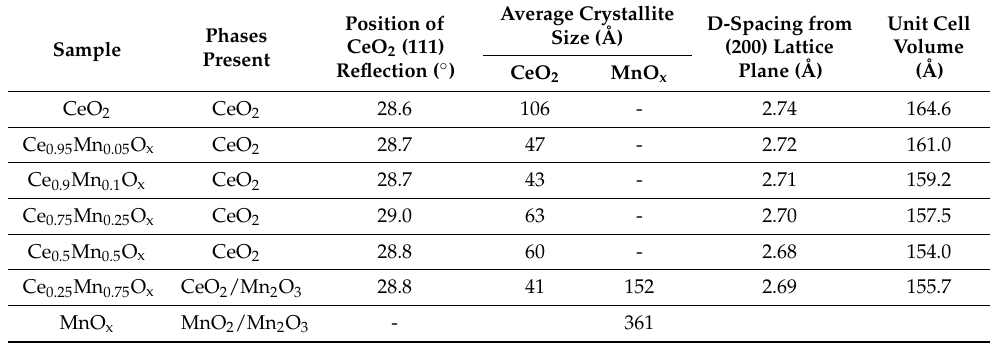
Table 1. Physiochemical properties extracted from XRD of cerium-manganese mixed metal oxide catalysts.